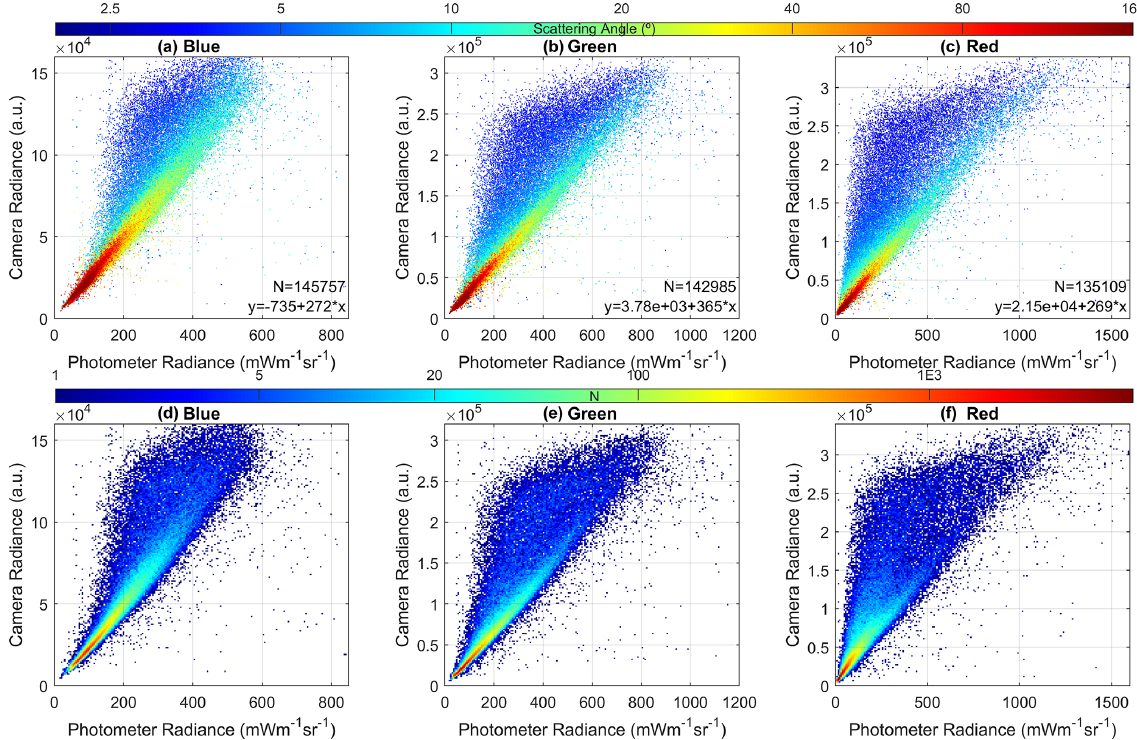
Figure 10. Camera sky radiance as a function of photometer radiances for blue (a, d) , green (b, e) and red (c, f) channels. Colour scale represents the scattering angle in panels (a) – (c) , while it means the amount of available data N in an interval (density plot) in panels (d) – (f) .